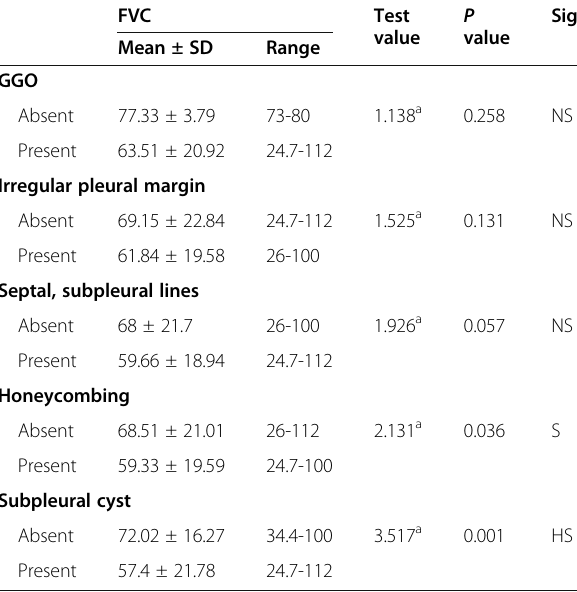
Table 6 Correlation between forced vital capacity and Warrick ’